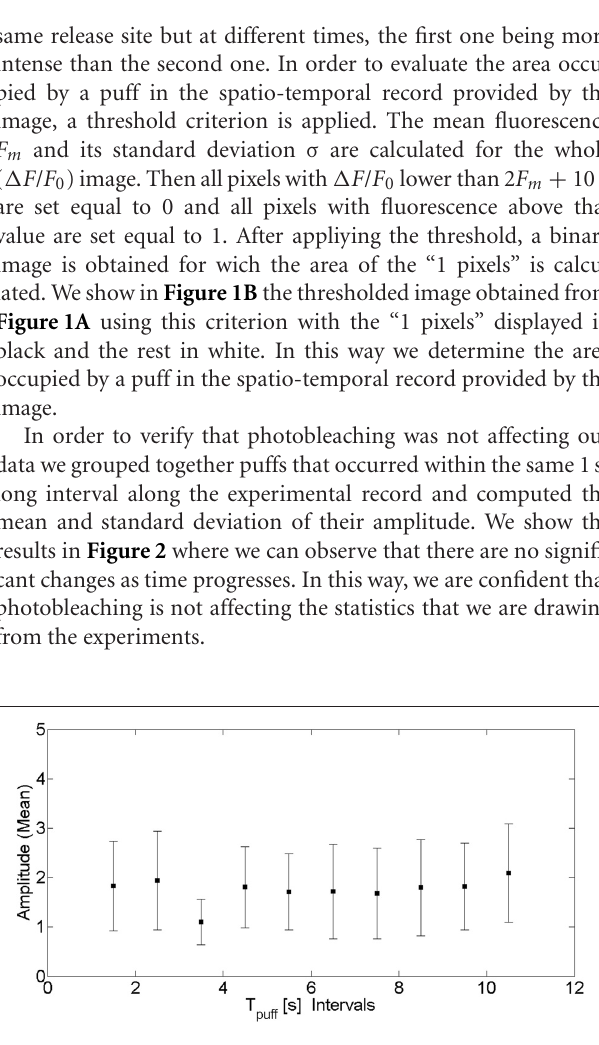
FIGURE 2 | Puff amplitude as funcion of puff occurrence. Mean amplitude (symbols) and corresponding standard deviation (vertical lines) of